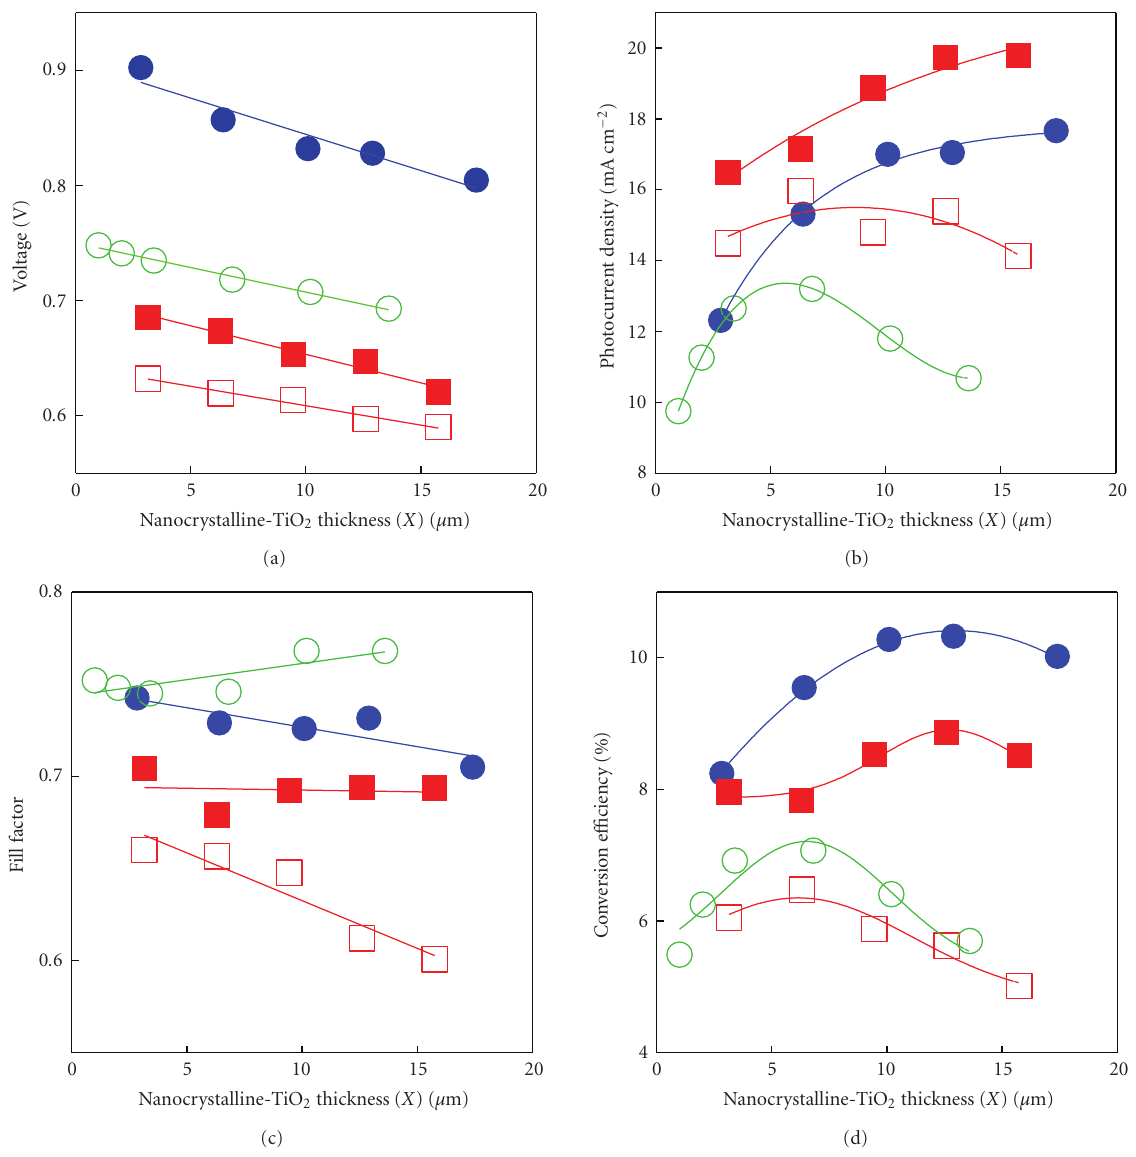
Figure 7: Photovoltaic characteristics in relation to the thickness of nanocrystalline-TiO 2 ( d = 20nm) layers in double-layer electrodes (as shown in Figure 1(b)): N719-sensitized solar cells using AcCN-based electrolytes (solid circles); K19-sensitized solar cells using ionic- liquid-based electrolytes (open circles); D149-sensitized solar cells using AcCN-based (solid square) and ionic-liquid-based (open square)